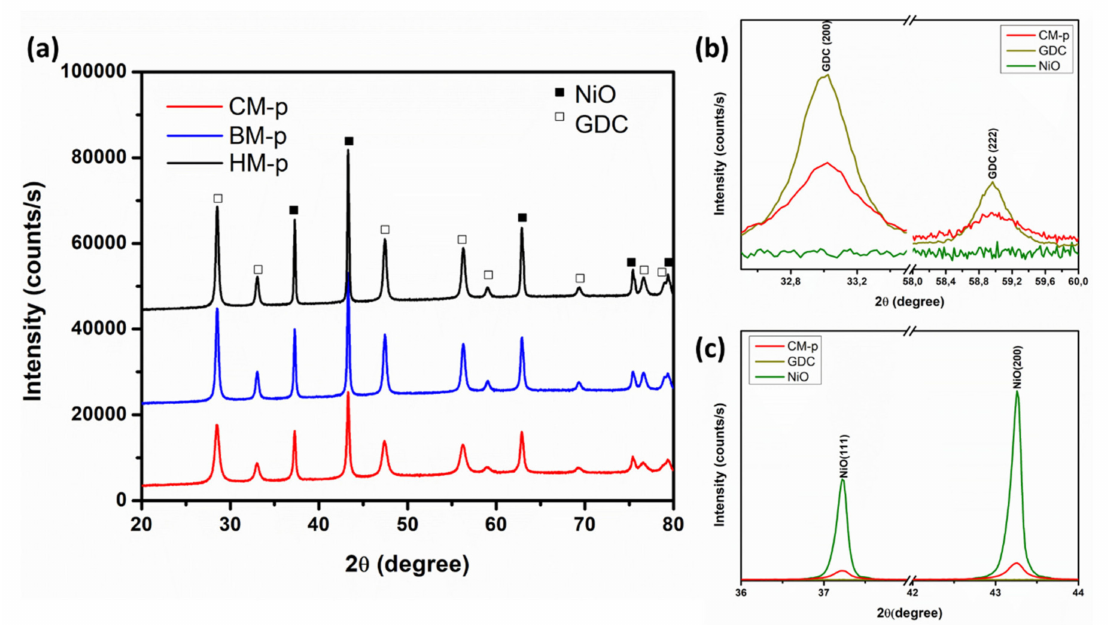
Figure 1. ( a ) XRD patterns of the NiO-GDC calcined powders obtained by CM, BM, and HM methods; ( b , c ) enlarged views of selected diffraction peaks of the CM-p for GDC and NiO phase, respectively, (p represents the calcined